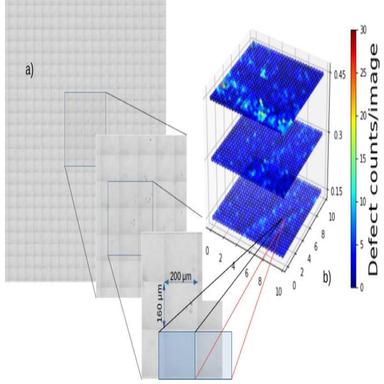
(a) Stitched images of a raw CdTe crystal (b) visualization of defect counts/image for three crystal layers after NN evaluation, dimensions in mm.